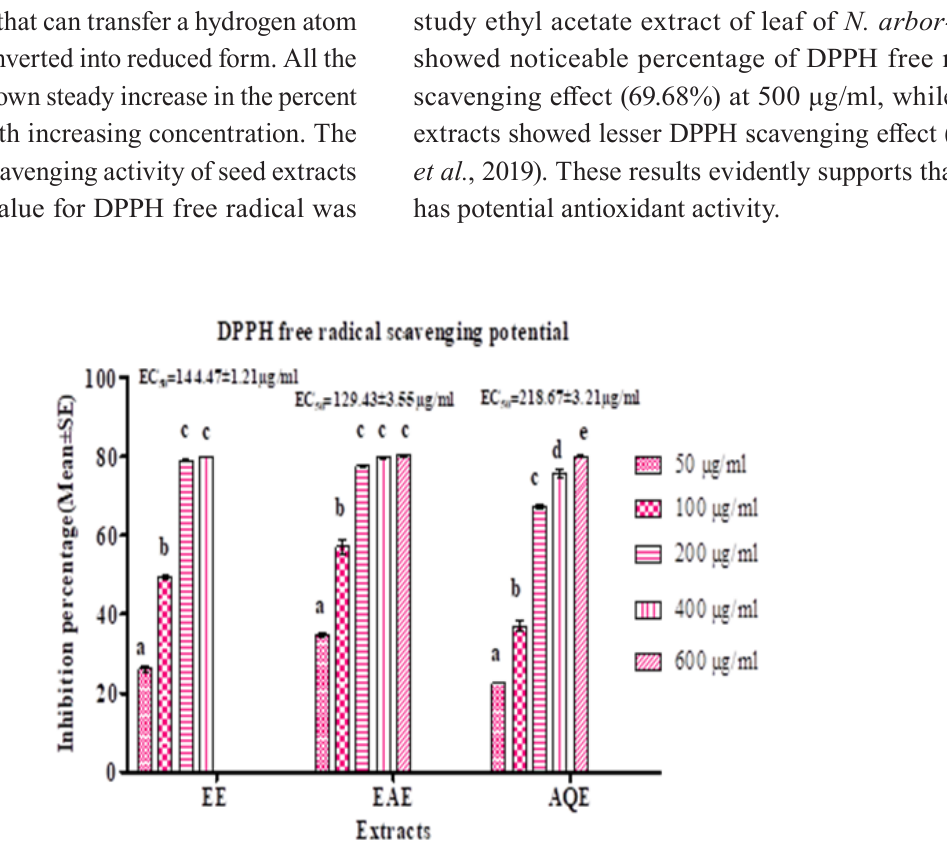
FIGURE 1 - DPPH free radical scavenging potential in different seed extracts of N. arbor-tristis L. Different letters indicate the significant differences from each other at P